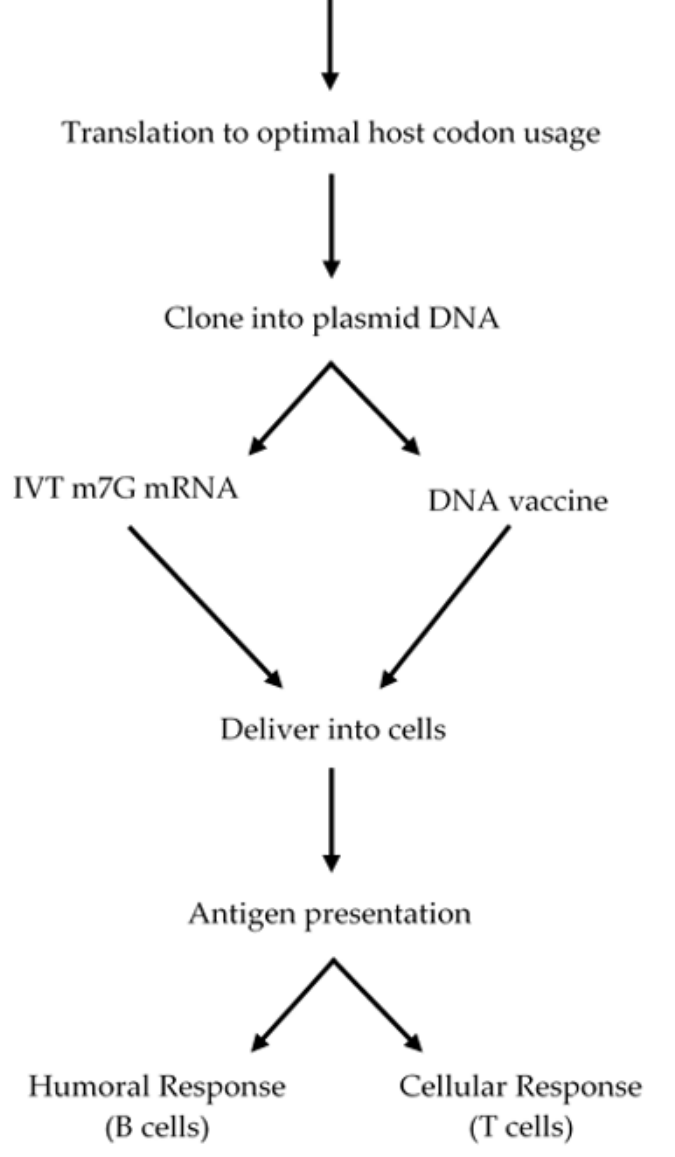
Figure 7. A strategy to design a mRNA-based vaccine. A polypeptide (antigen) is chosen to develop a vaccine and then the whole polypeptide or antigenic regions are selected by using bioinformatic programs. The cDNA is synthesized using the codon usage of the species to be vaccinated. The cDNA is cloned into a plasmid DNA vector as described in Figure 6 and then in vitro transcribed (IVT) and capped (m7G mRNA). The m7G mRNA is purified and incorporated into liposomes or another carrier and then injected into the individuals. The m7G mRNA enters the cytosol and is translated by the ribosomes and presented to immune system cells (Figure 3) to produce antibodies, cytotoxic T cells and B and T memory cells.